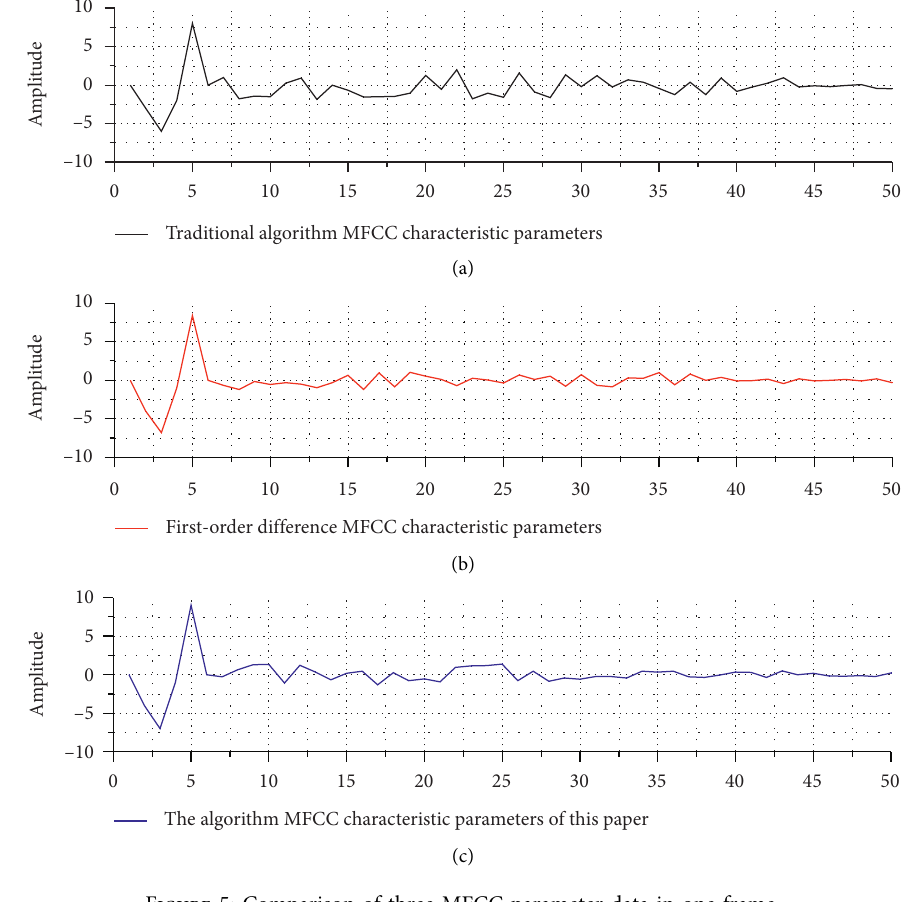
Figure 5: Comparison of three MFCC parameter data in one frame.